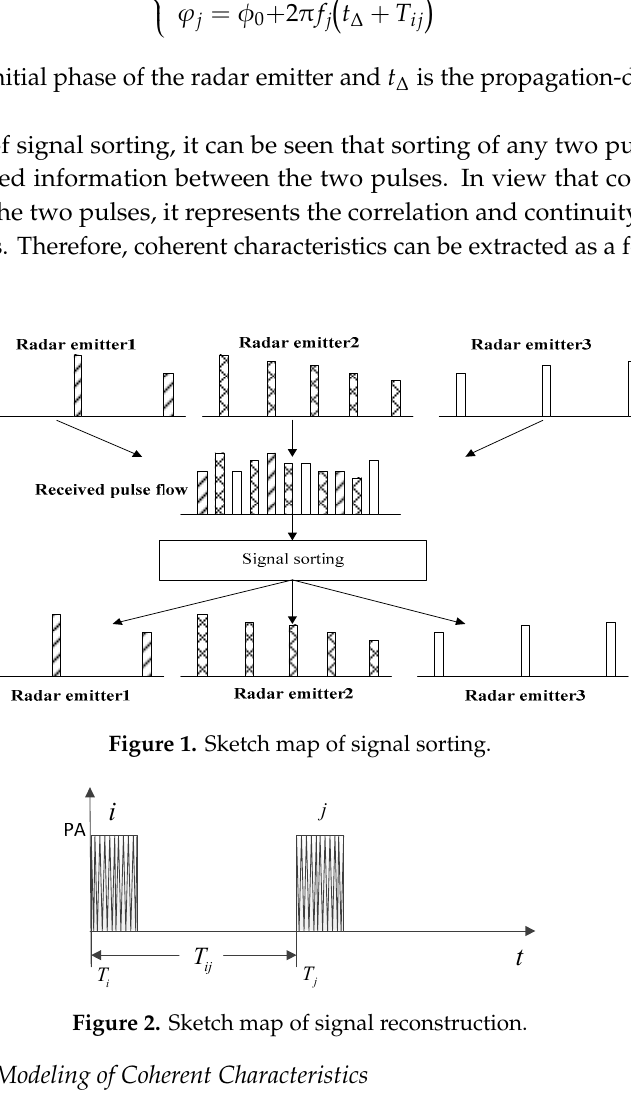
Figure 2. Sketch map of signal reconstruction.